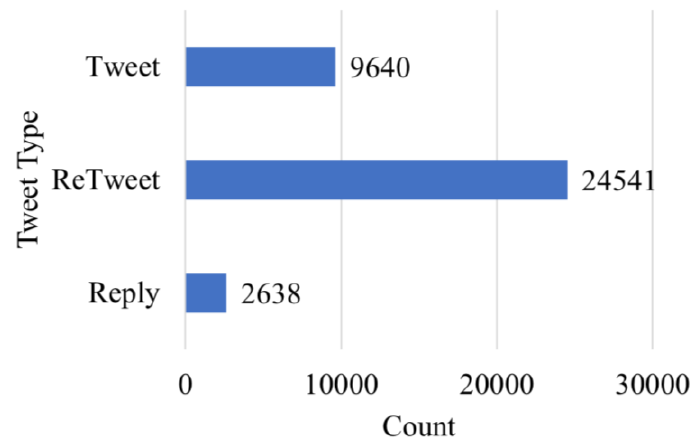
Figure 4. Distribution of tweets according to tweet type:original tweet, retweet, and reply tweet.